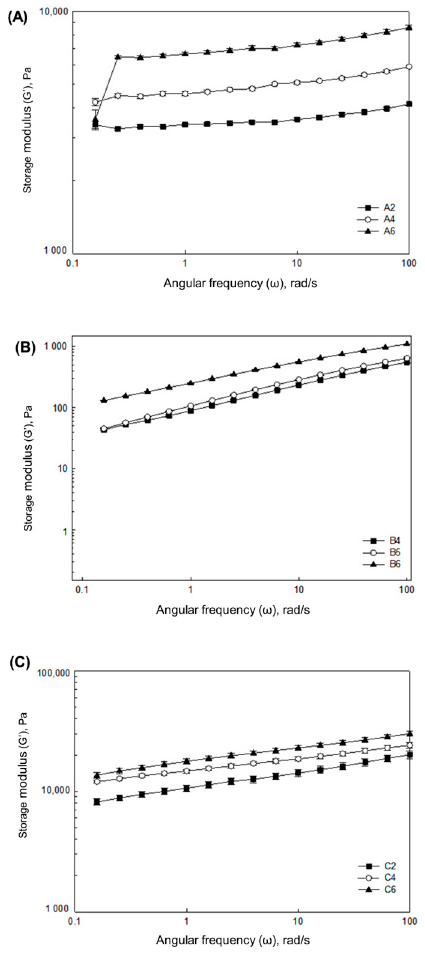
Figure 1. Oscillatory frequency sweeps for the selected gel formulations of A ( A ), B ( B ), and C ( C ) for 3D printing. A2, A4, and A6; B4, B5, and B6; and C2, C4, and C6 are the selected formulations from the formulations of A, B, and C,